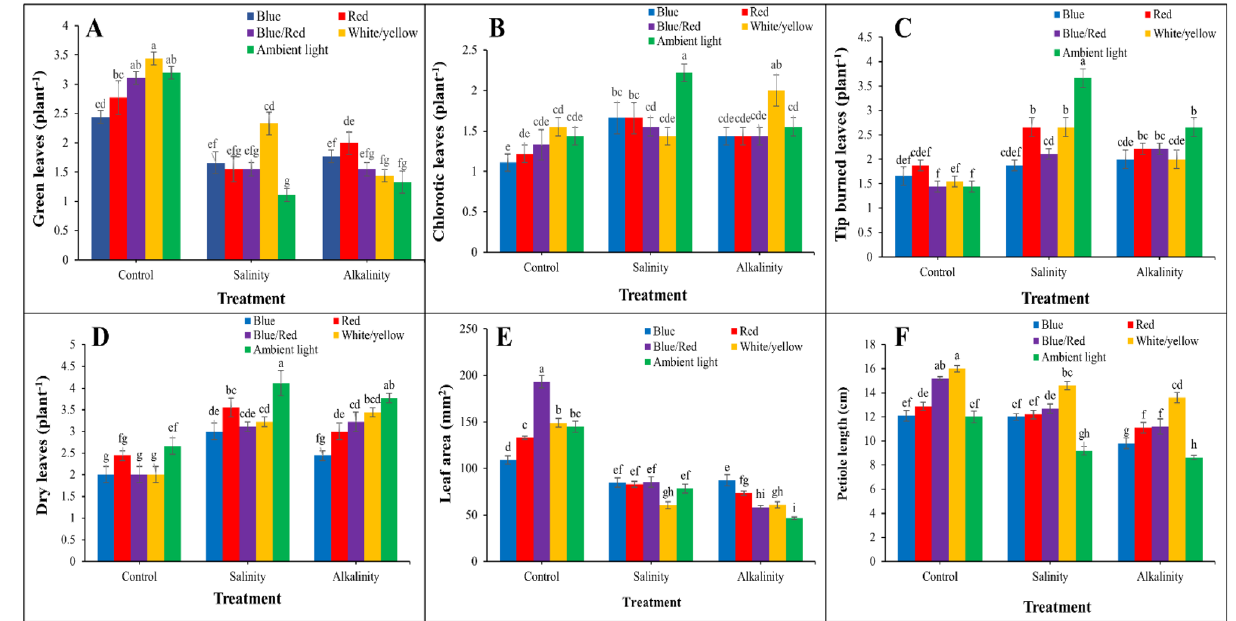
Figure 2. Changes in ( A ) green leaves; ( B ) chlorotic leaves; ( C ) tip burned leaves; ( D ) dry leaves; ( E ) leaf area; ( F ) petiole length under the effect of five light spectrum levels and three stress levels in three repetitions in strawberries cv. Camarosa. Means followed by the same letter for a parameter, are not significantly different according to Duncan (P ≤ 0.05). Vertical bars indicate the standard errors of three replicates. SAS software version 9.4 was used for data analysis. The graphs were drawn using Microsoft Excel (2016).